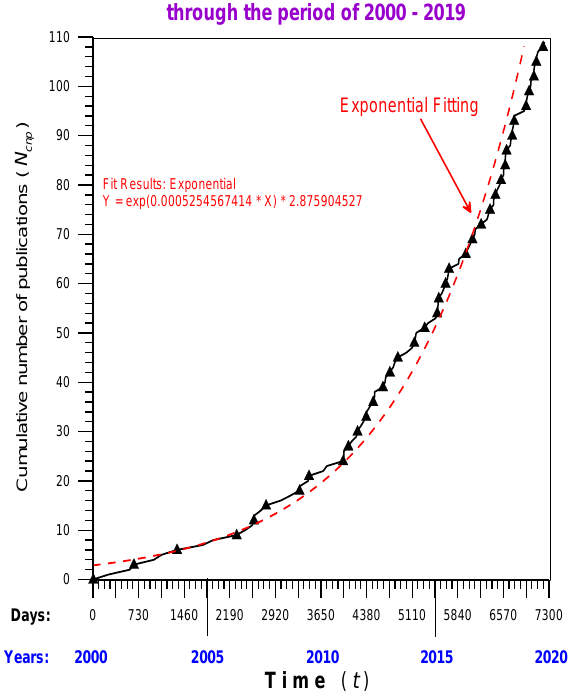
Figure 10. Thediagram presents the cumulative number of publications with regard to OHS RACs Figure 10. The diagram presents the cumulative number of publications with regard to ΟΗS RACs against time, through the period of against time, through the period of 2000 – 2019.